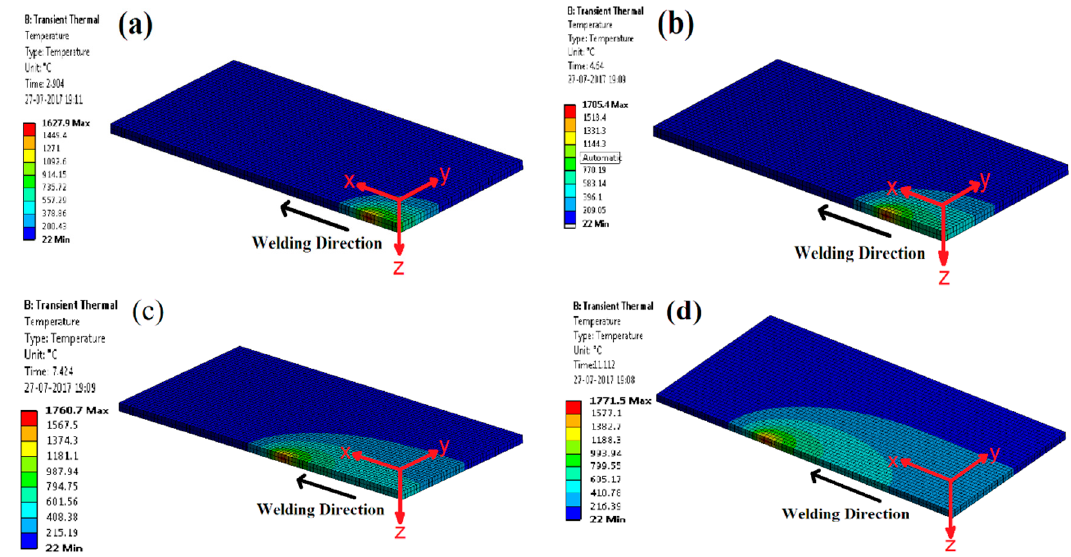
Figure 6. Transient temperature distribution at different time steps: ( a ) t = 2.904 s; ( b ) t = 4.64 s; ( c ) t = 7.424 s; ( d ) t = 11.112 s.